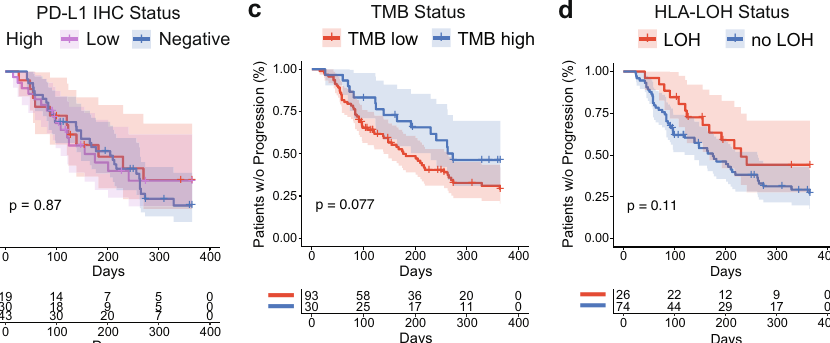
Fig. 1 Cohort clinical and genomic characteristics. a Mutation plot showing the distribution of TMB and frequency of driver mutations across the cohort ( n = 123). Each column represents a patient and columns are ordered by TMB. Immunotherapy biomarker status and mutation type are denoted by color. Genes are sorted by frequency of mutation. b Kaplan – Meier plots showing time to progression on ICB therapy, strati fi ed by PD-L1 IHC status ( n = 92, p = 0.87, log-rank), c TMB status ( n = 123, HR = 0.60, p = 0.083, log-rank), and d HLA-LOH ( n = 100, HR = 1.64, p = 0.11, log-rank). Source data are provided as a Source Data fi HLA-I (HR = 0.61, p = 0.11, log-rank). There was no signi fi cant association between B2M mutation or HLA homozygosity and TTP ( B2M : HR = 1.24, p = 0.77, HLA homozygosity: HR = 0.88,